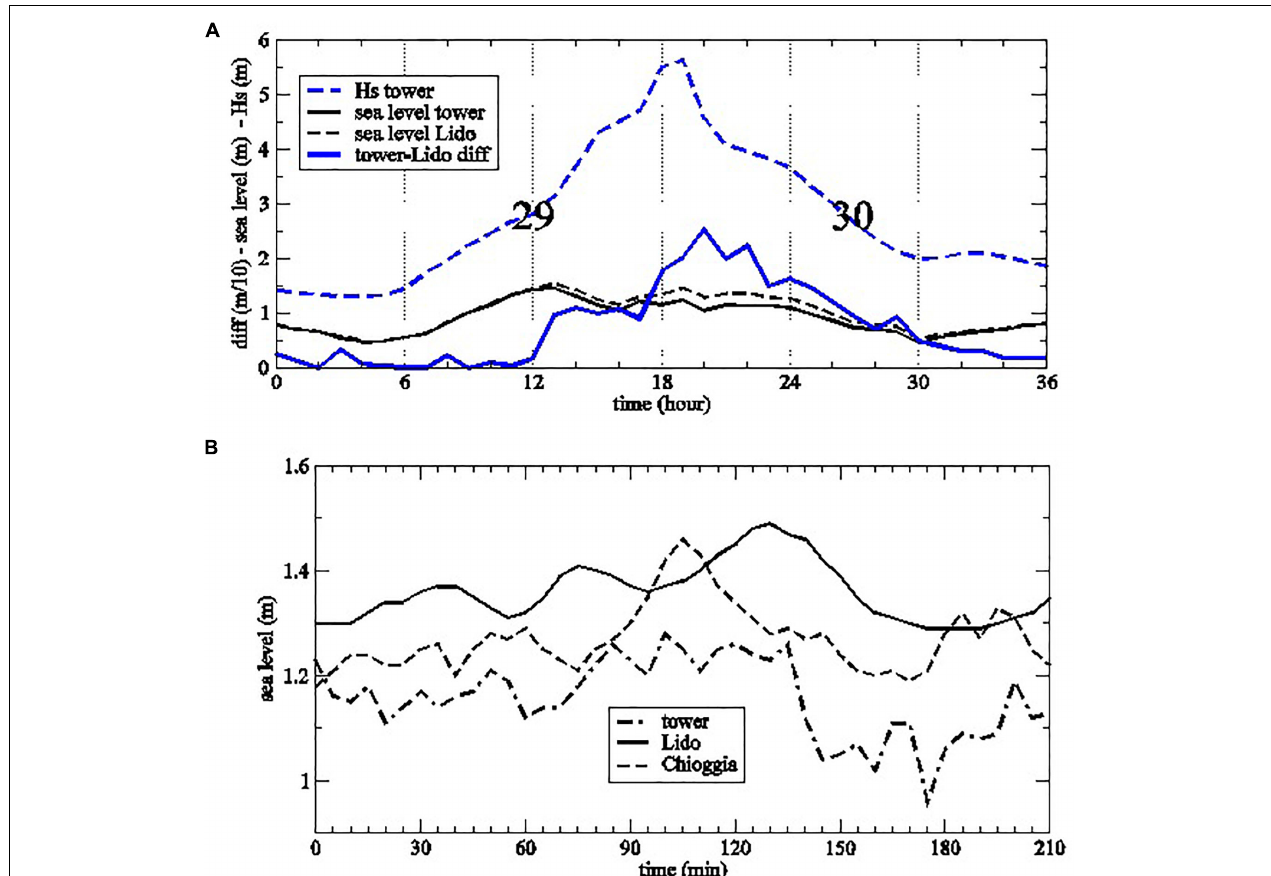
FIGURE 13 | Time evolution and relationship between H S at the Aqua Alta tower (Northern Adriatic Sea pilot) and the sea level differences between the coastal (termed Lido) and the tower tide gauges (A) together with mean sea level variations between the tower and two coastal gauges (B) . Note the sharp gradients occurring at 135 min at the tower signal, associated to the passage of the cold front on 29–30th October, 2018. Large numbers in the top plot indicate the day within the event duration.